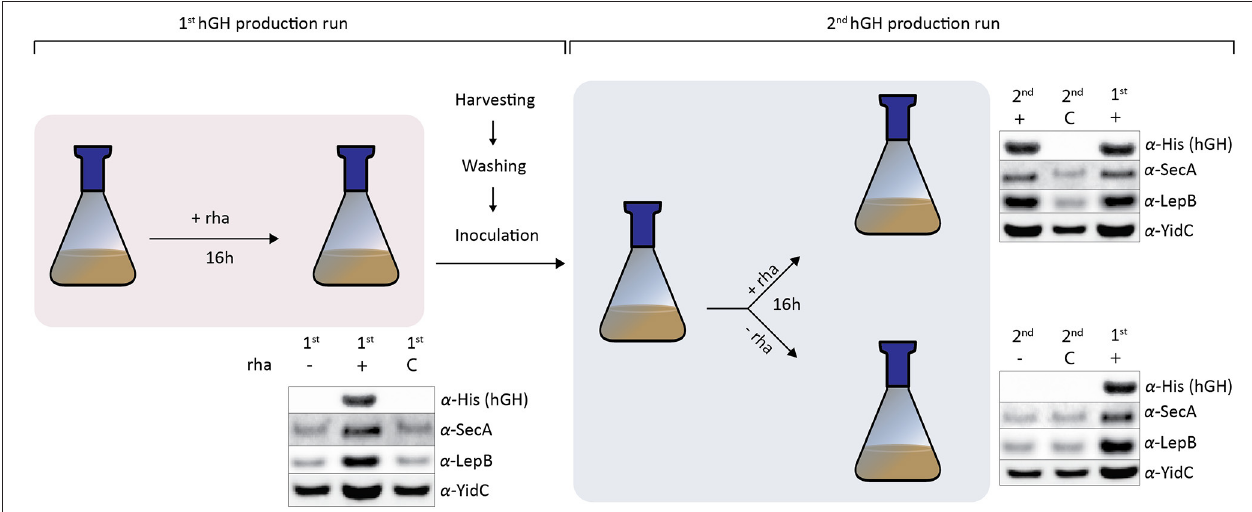
FIGURE 3 | Cells increase their SecA, LepB, and YidC levels in response to enhanced periplasmic hGH production. In the first hGH production run using Hbp sp , 16h after induction with rhamnose, hGH, SecA, LepB, and YidC accumulation levels were monitored by means of SDS-PAGE/immuno-blotting. Cells with a pRha- hbp sp hghhis 6 expression vector to which no inducer (–) was added and cells with an empty expression vector (C) cultured in the presence of inducer were used as controls. The accumulation levels of hGH, SecA, LepB, and YidC were monitored using antisera against the C-terminal His 6 -tag of hGH, SecA, LepB, and YidC. For SecA, LepB, and YidC a secondary fluorescently labeled antibody was used for visualization. Equal amounts of cells based on A 600 measurements were loaded. To set up the second hGH production run, cells producing hGH and control cells with an empty expression vector were extensively washed in medium without rhamnose and used to inoculate fresh cultures. When the culture had reached an A 600 of ∼ 0.5 the culture was split. To one half of the culture rhamnose was added and to the other half no rhamnose was added. 16h after the addition of rhamnose in the second hGH production run, cells were harvested and hGH, SecA, Lep, and YidC levels were monitored as described above. Cells producing hGH in the first hGH production run were included as a